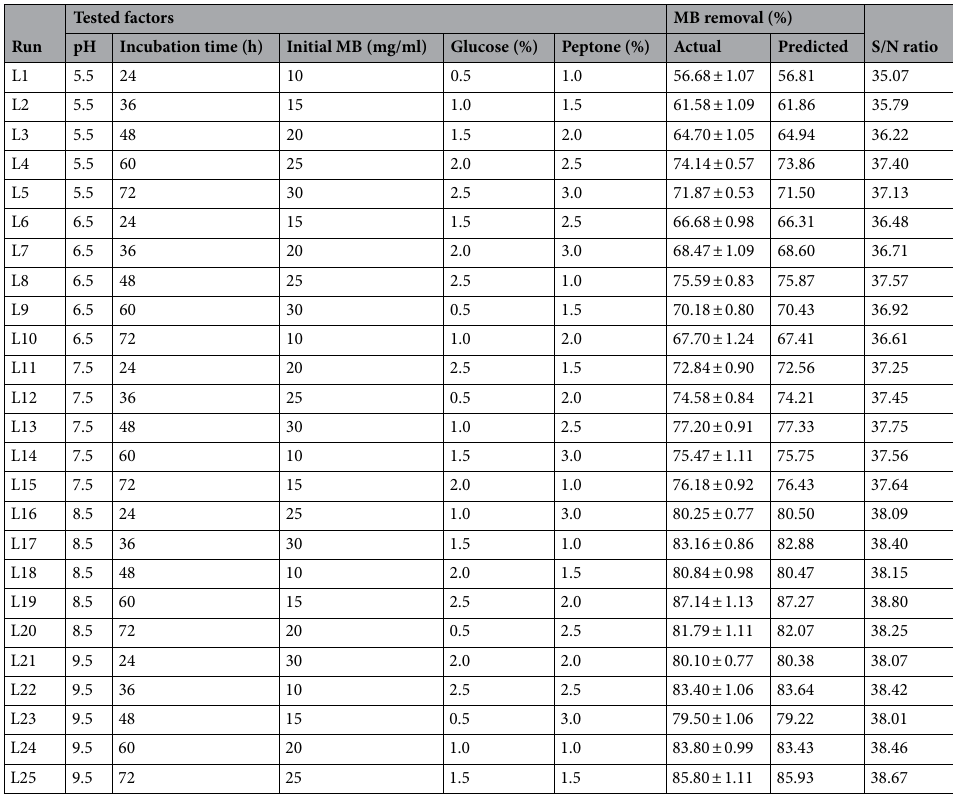
Table 1. Taguchi’s L 25 (5 5 ) orthogonal array, and S/N ratio for optimization of MB biosorption, using P. alcaliphila